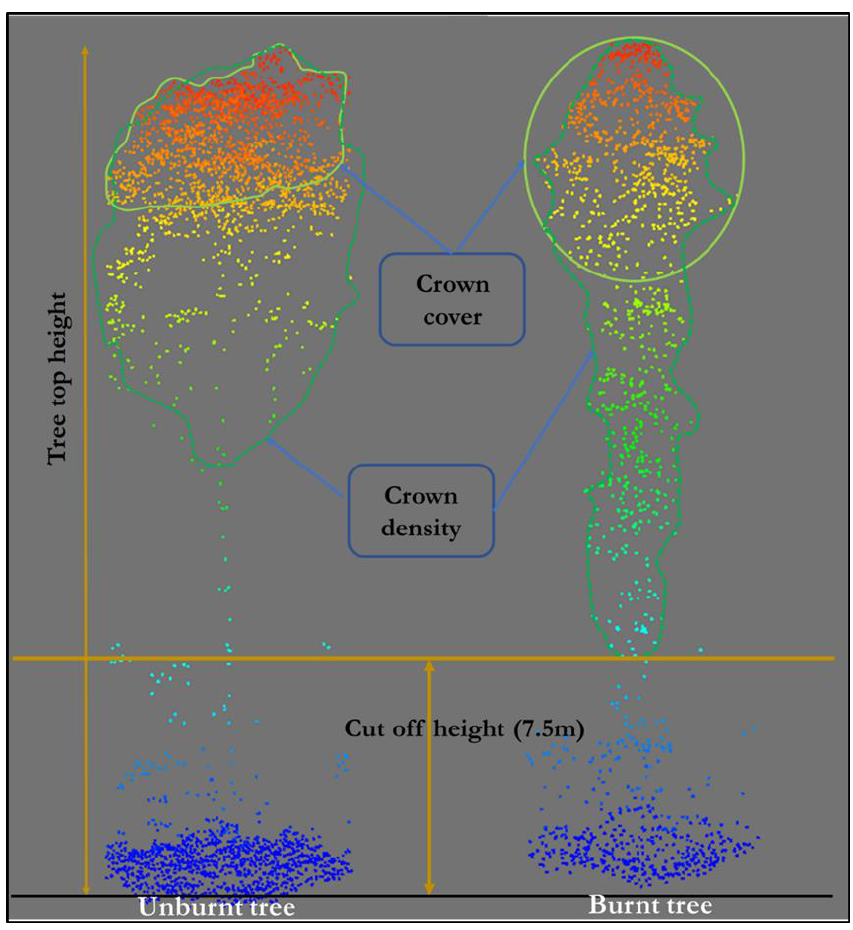
Figure 4. Illustration of the crown cover and crown density LiDAR metrics for individual unburnt and burnt trees as estimated from the LiDAR point cloud.